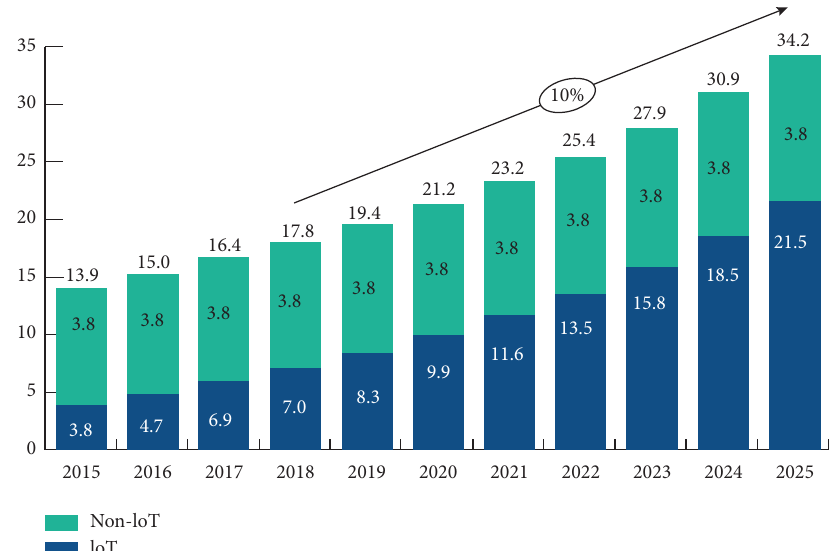
Figure 3: Total number of active device (IoT and Non-IoT) connections